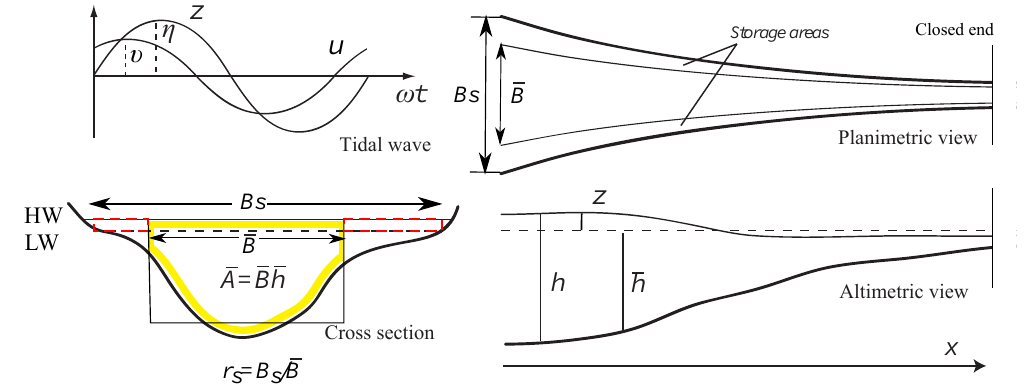
Figure 1. Geometry of a semi-closed estuary and basic notation (after Savenije et al., 2008). HW, high water; LW, low